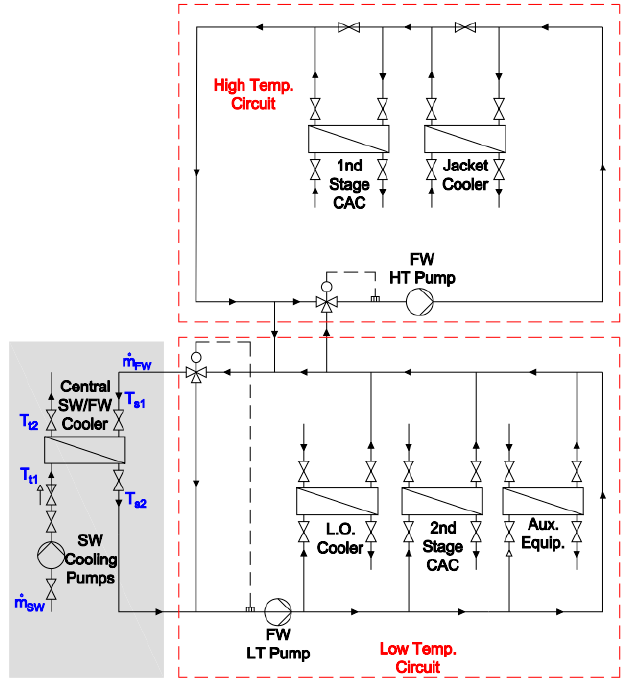
Figure 1. Typical central cooling system used in marine applications. Explanation of abbreviations: Aux. = Auxiliary, CAC = Charge air cooler, FW = fresh water, L.O. = Lubricant oil, SW = seawater, LT = Low temperature.